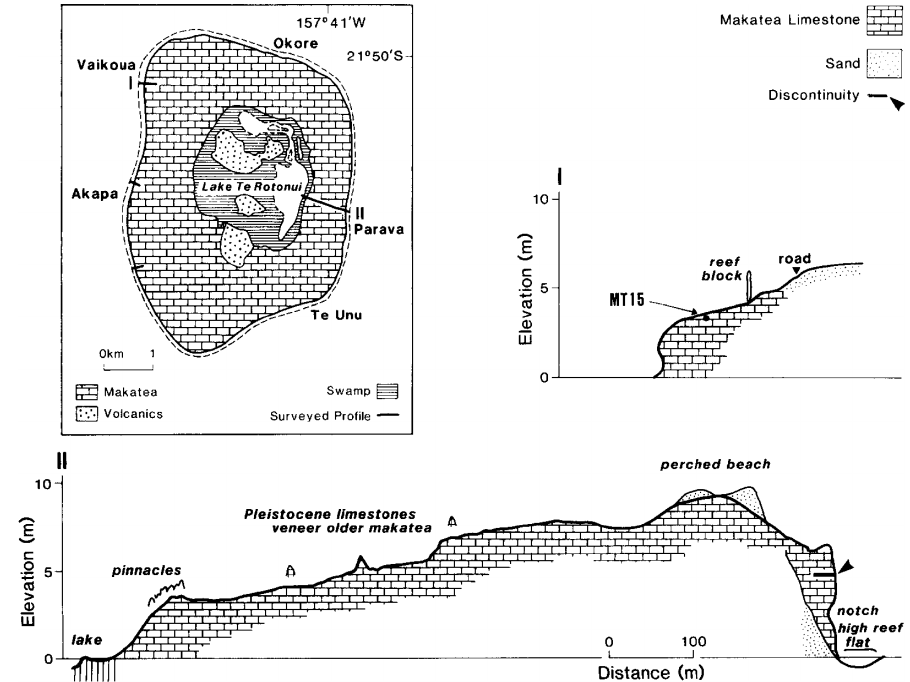
Figure 19. Sea-level indicators on Mitiaro, Cook Islands. Selected profiles and dated samples are shown (from Woodroffe et al., 1991).